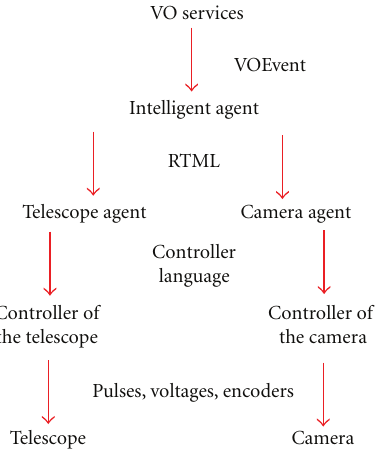
Figure 1: Simple schema of agents used in an autonomous robotic observatory.